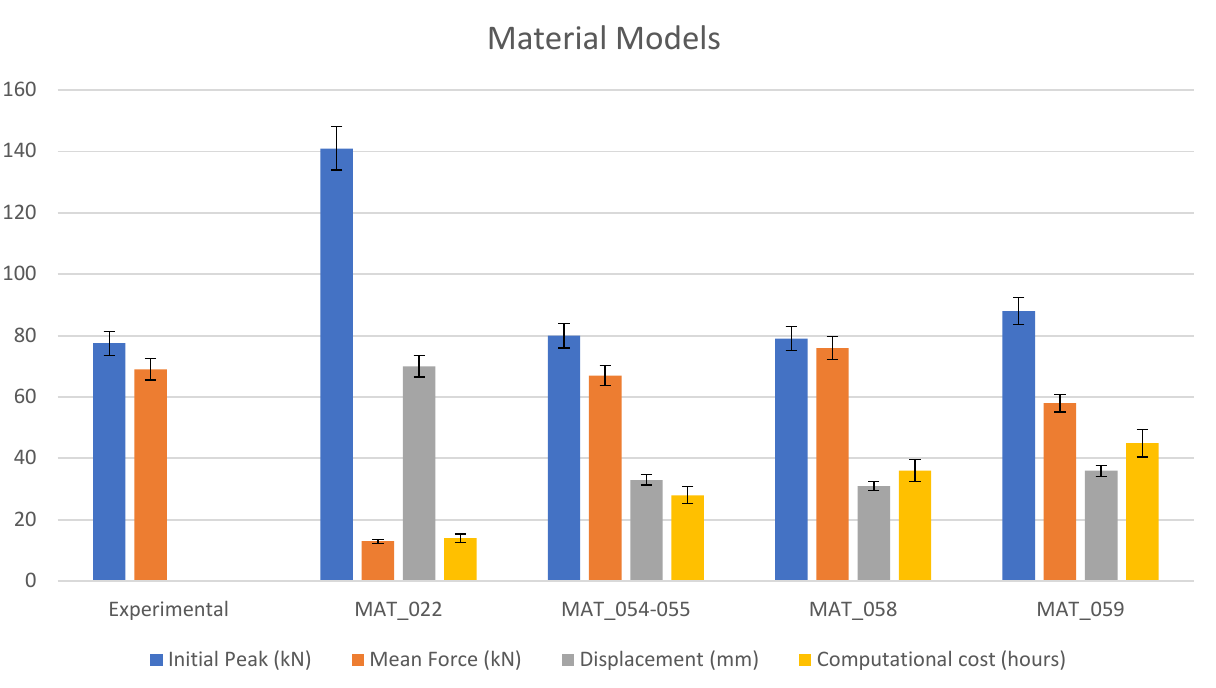
Figure 4. Material model comparison [66].